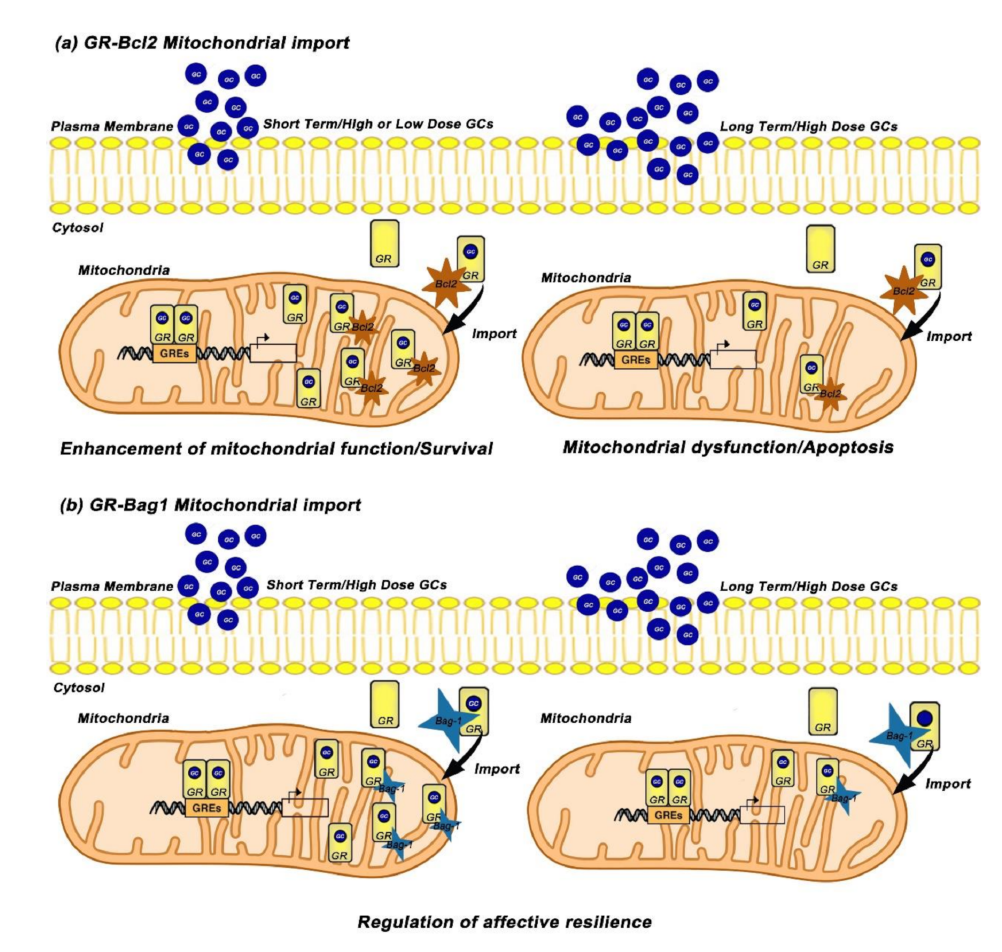
Figure 2. GCs exert biphasic effects on mitochondrial GR translocation and on the formation of GR/Bcl2 and GR/Bag-1 complexes in mitochondria of cortical neurons. ( a ) Short-term treatment with high or low doses of Cort induces the mitochondrial localization of GRs and leads to increase of the GR/Bcl-2 complex into mitochondria, thus enhancing mitochondrial function and neuronal viability. Long term treatment with high doses of Cort reduces the mitochondrial localization of GRs and downregulates GR/Bcl-2 complex in mitochondria, leading to mitochondrial dysfunction and apoptosis [27]. ( b ) Short-term treatment with high doses of Cort enhances the formation of GR/Bag-1 complex and GR mitochondrial localization while long-term treatment with high doses of Cort reduces the mitochondrial GR and GR/Bag-1 colocalization. Chronically Cort-treated Bag-1 overexpressing mice blocked the decrease in mitochondrial GR, reversed the anhedonia-like behavior as well as the depressive-like behavior induced by chronic Cort treatment compared to wild type mice, suggesting that Bag-1 regulates resilience from depressive-like impairments [68]. GCs; Glucocorticoids, GR; Glucocorticoid Receptor, GREs; Glucocorticoid Response Elements, Bcl2; B-cell lymphoma-2, Bag-1; Bcl-2-associated athanogene, Cort;